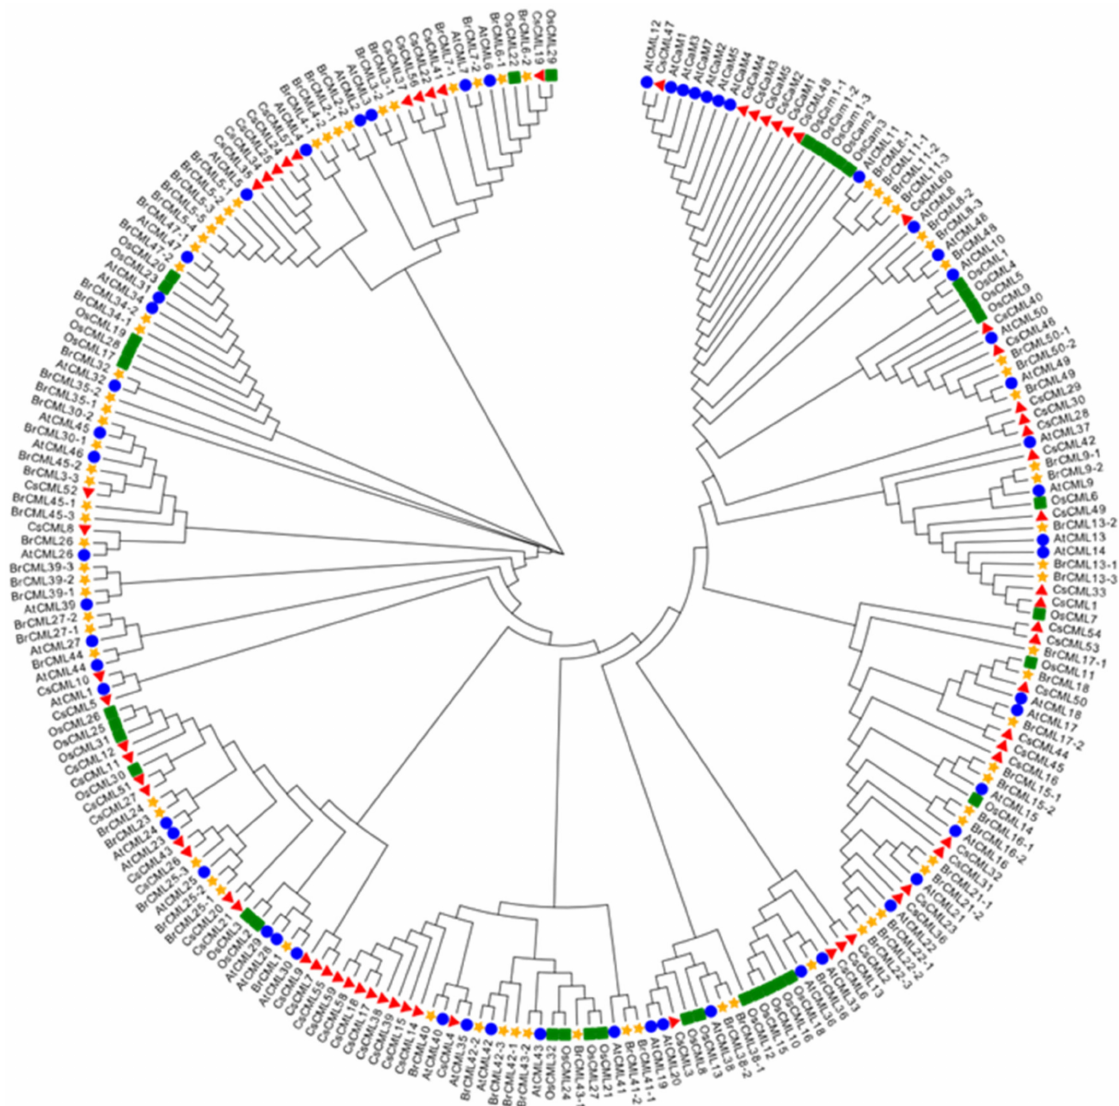
Figure 4. Phylogenetic relationships of CaM/CML genes from Camellia sinensis and other species. The phylogenetic tree was constructed based on sequence alignment of CaM/CML homologs from Camellia sinensis , Arabidopsis , rice, and cabbage using the neighbor-joining method with bootstrapping analysis in MEGA 7.0 (bootstrap:1000). The red triangles represent Camellia sinensis ; the blue circles represent Arabidopsis ; the green squares represent rice; the yellow stars represent